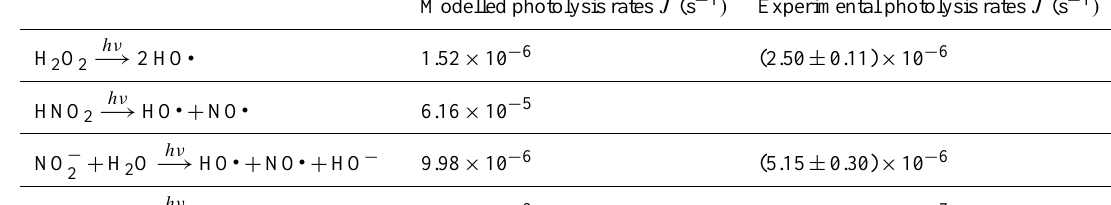
Table 4. Modelled photolysis rates calculated by the model versus experimental photolysis rates obtained from experiments reported in Fig. 3. Modelled photolysis rates J (s − 1